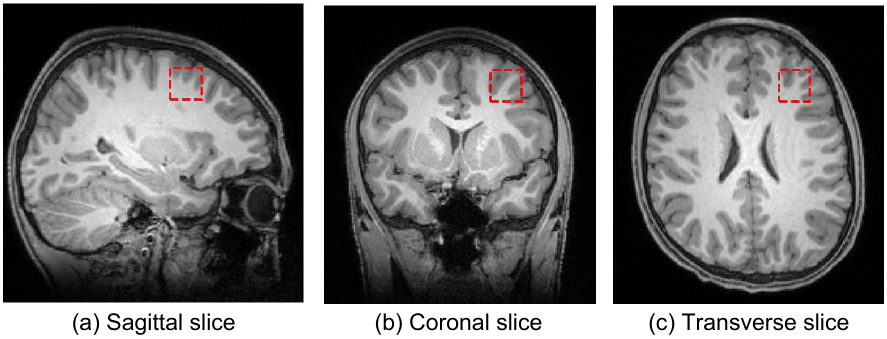
Figure 1. The T1-weighted MRI and the left MFG region. Three subplots are ( a ) a sagittal slice from left to right, ( b ) a coronal slice from top to bottom, and ( c ) a transverse slice from back to front,